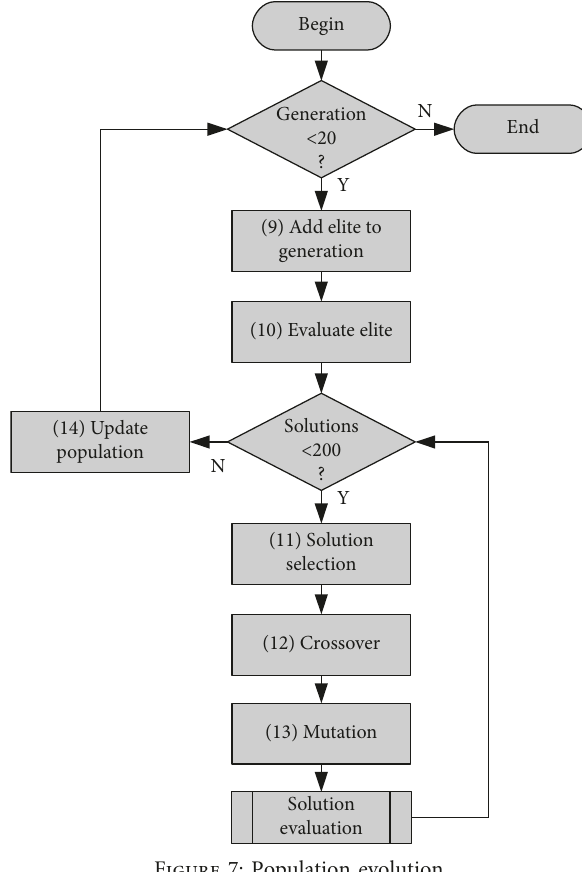
Figure 7: Population